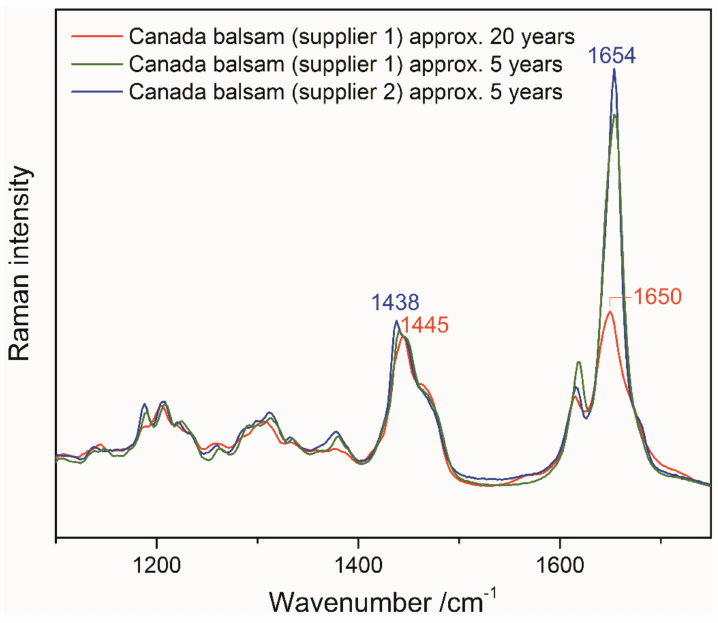
Figure 13. Raman spectra of Canada balsam samples from two different suppliers after different shelf storage